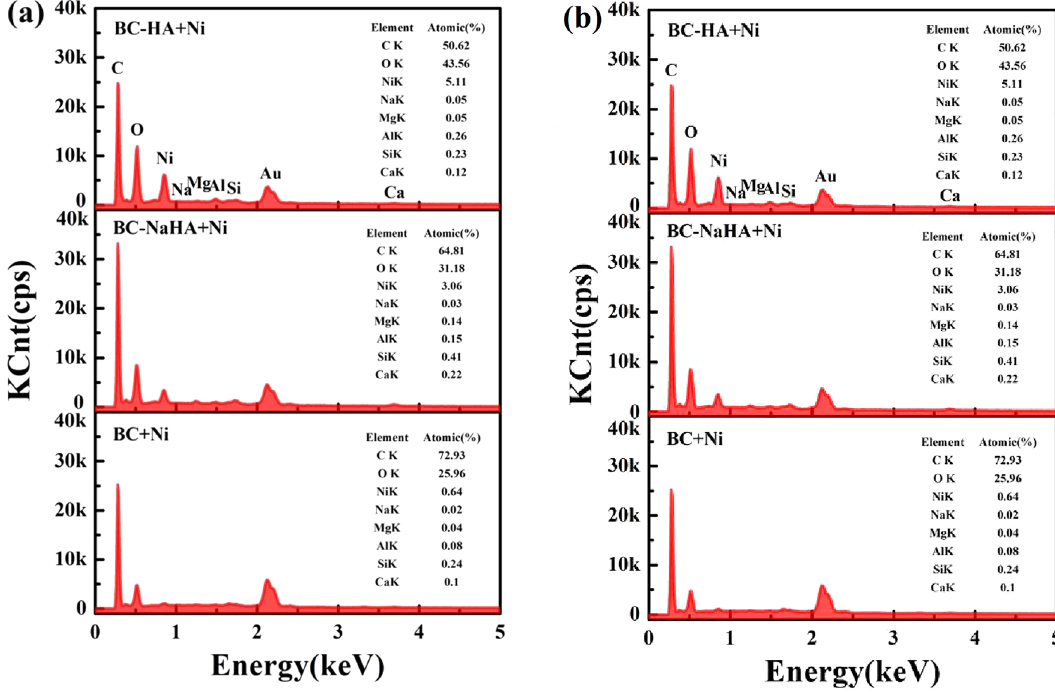
Figure 7. EDS spectrum of ( a ) BC, BC-NaHA, BC-HA; ( b ) BC + Ni, BC-NaHA + Ni, BC-HA +